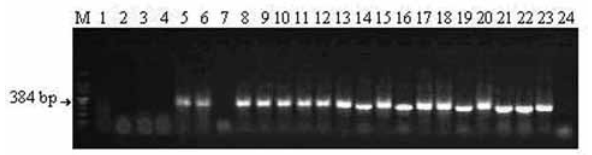
Fig. 1. – Products of amplification of gene fragment encoding β -giardin of G. intestinalis obtained from dnA isolated with protocol 8 B (3x boiling (100 °c/2 min) and freezing in liquid nitrogen (2 min), QiAamp dnA tissue mini kit, QiAGen, incubation with proteinase 56 °c/night)